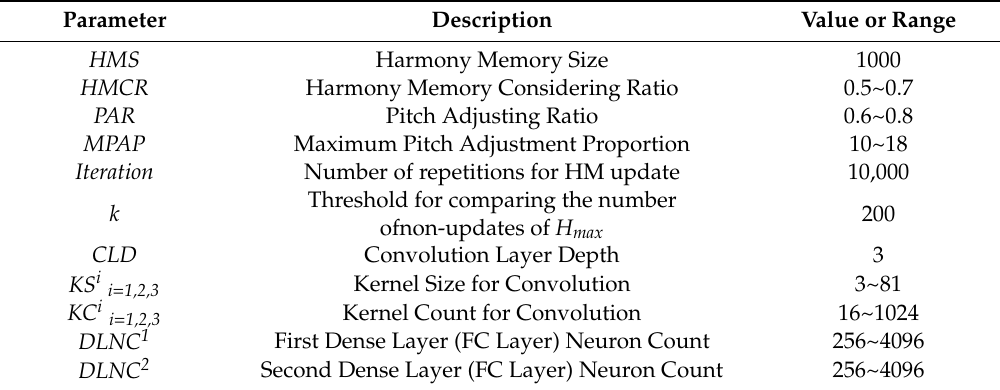
Table 7. Hyperparameters used in proposed method and range of each parameter value.